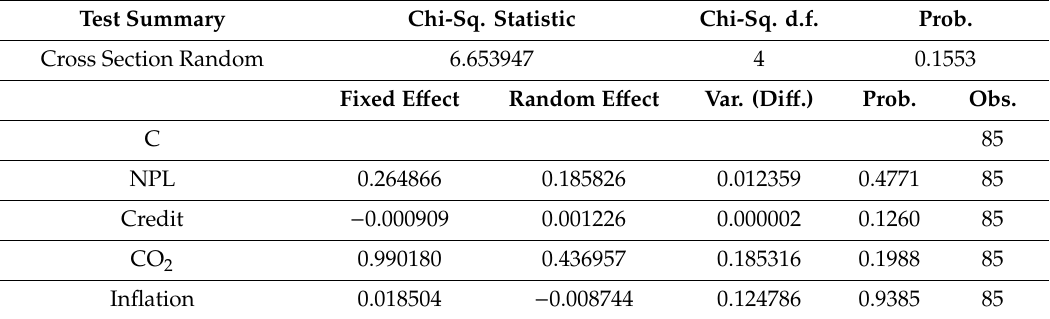
Table 3. The Hausman